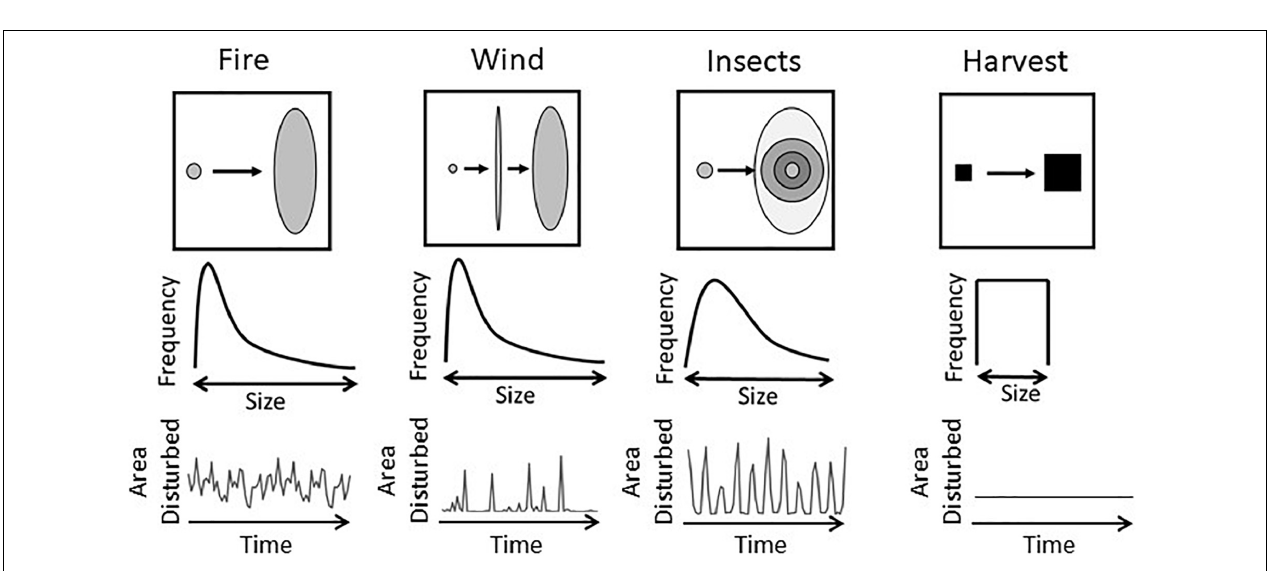
FIGURE 2 | Disturbance regimes are traditionally characterized according to size distributions, shapes (e.g., wind), degrees of intensity (e.g., grayscale under insects), and temporal patterns.